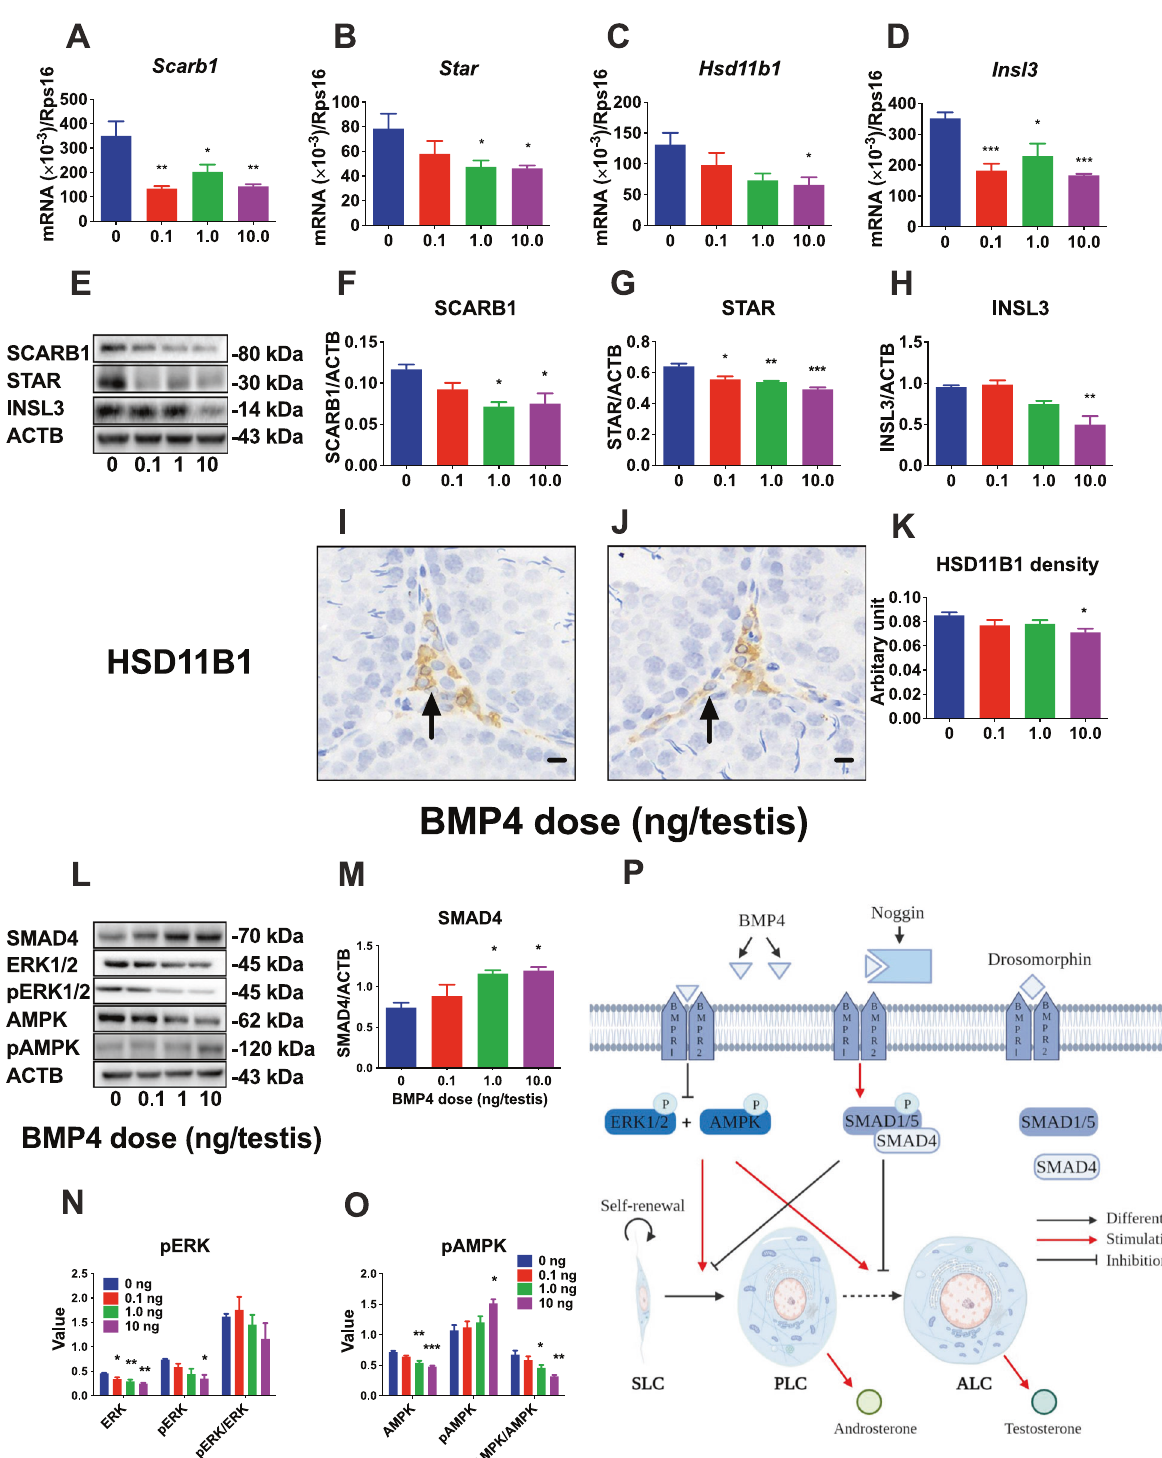
Fig. 8 Gene and protein expression in Leydig cells after BMP4 treatment in vivo. A – D Scarb1, Star, Hsd11b1 , and Insl3 mRNAs in the testes of rats treated with 0, 0.1, 1.0, and 10.0 ng/testis BMP4 for 14 d after EDS were analyzed by qPCR and normalized to Rps16 ; Mean ± SEM, n = 6. E – H Protein levels of SCARB1, STAR, INSL3 were measured by Western blot and normalized to ACTB, Mean ± SEM, n = 3. I – K Semi-quantitative measurement of HSD11B1 density after in vivo BMP4 treatment (0 and 10 ng/testis). Black arrows indicate HSD11B1 + . Mean ± SEM, n = 6, Bar = 50 μ m. L Protein levels of kinase, phosphorylated kinase protein, and SMAD pathway protein levels after BMP4 treatment in vivo. (M-O) Quantitative data for SMAD4, ERK1/2, and AMPK, and their phosphorylated proteins as well as their ratio; Mean ± SEM, n = 3 – 4. * P < 0.05, ** P < 0.01, and *** P < 0.001 indicate signi fi cant differences compared to control (0 ng/testis BMP4). P Graphic Abstract. Mechanism of BMP4 regulating the development of stem/progenitor Leydig cells into adult Leydig cells. BMP4 has SMAD-dependent signaling: it binds to the BMPR to form complex, activating BMP-SMAD signaling; and SMAD-independent signaling: it blocks ERK1/2 and AMPK phosphorylation; thereby leading to the delay of Leydig cell regeneration or development. Cell Death and Disease (2022)